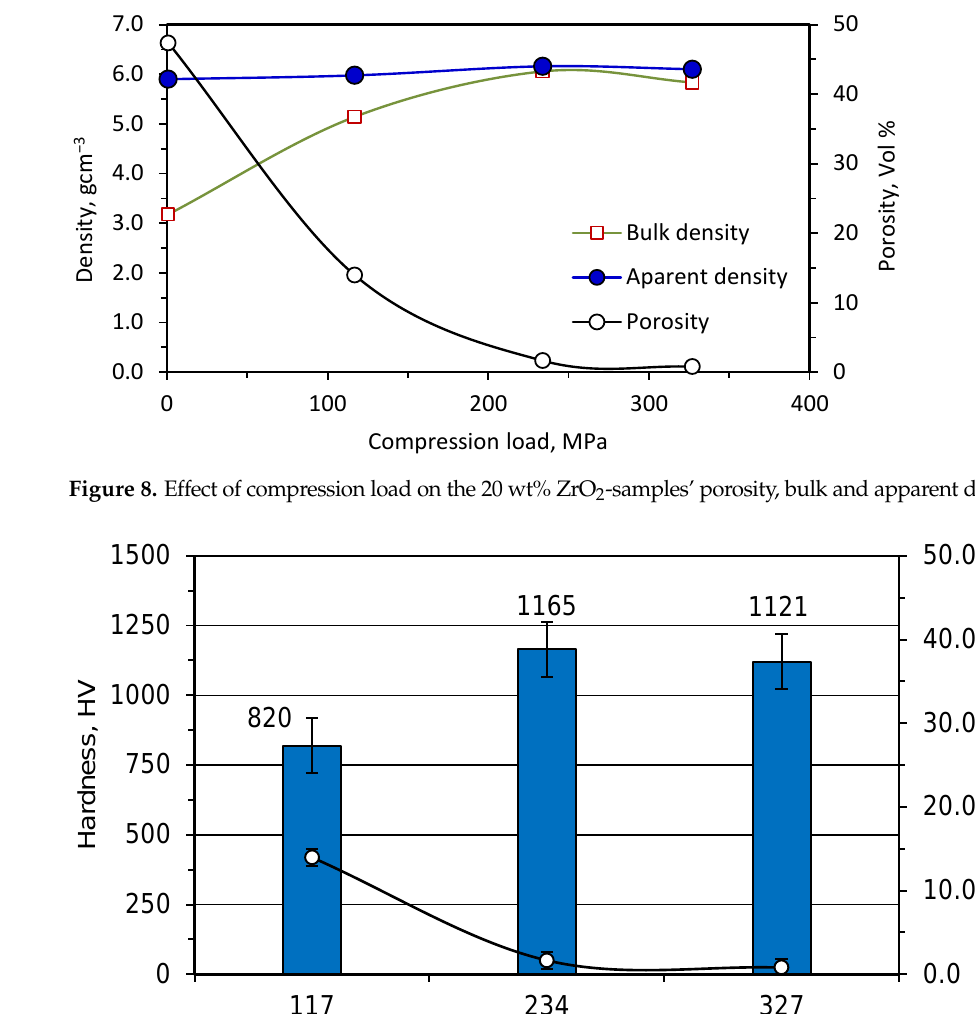
Figure 9. Effect of pressing load on the samples’ hardness (bars) and porosity (data points) reinforced with 20 wt% ZrO 2 .